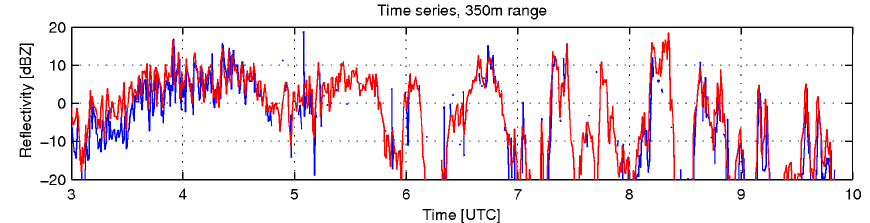
Fig. 11. Time series of lidar-retrieved radar reflectivity (blue) versus observed (red) at 350m. Note periods where retrieved value is missing is where cloud base was ≤ 350 m.